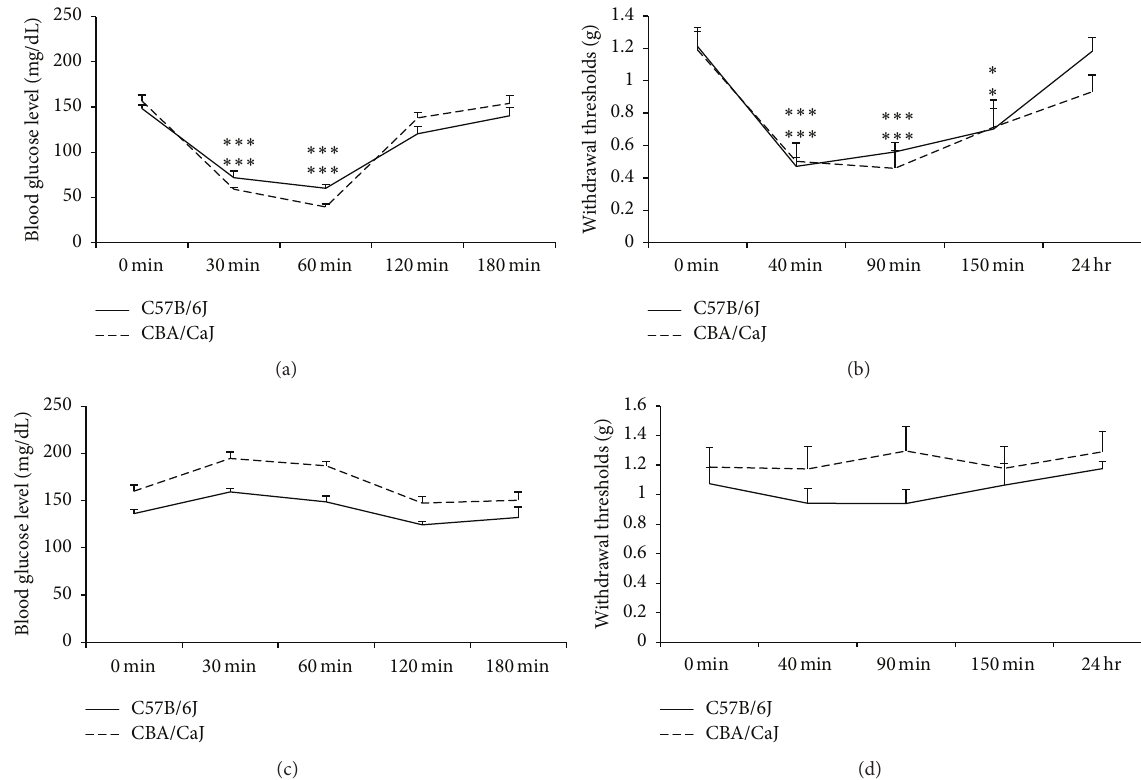
Figure 1: Effect of insulin treatment on glycemic levels and mechanical sensitivity. (a) Insulin injection decreases blood glucose levels at 30 and 60 min after insulin injection. (b) Mechanical sensitivity is increased (shown as decreased withdrawal thresholds) at 40, 90, and 150min after insulin treatment. (c) Normal saline as control of insulin does not significantly affect blood glucose level or mechanical sensitivity (d). ∗ and ∗ ∗ ∗ represent 𝑝 < 0.05 and 𝑝 < 0.001 , respectively, with ANOVA